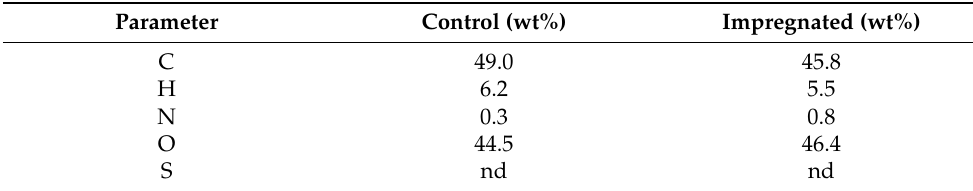
Table 3. Ultimate analysis of control and nickel-impregnated